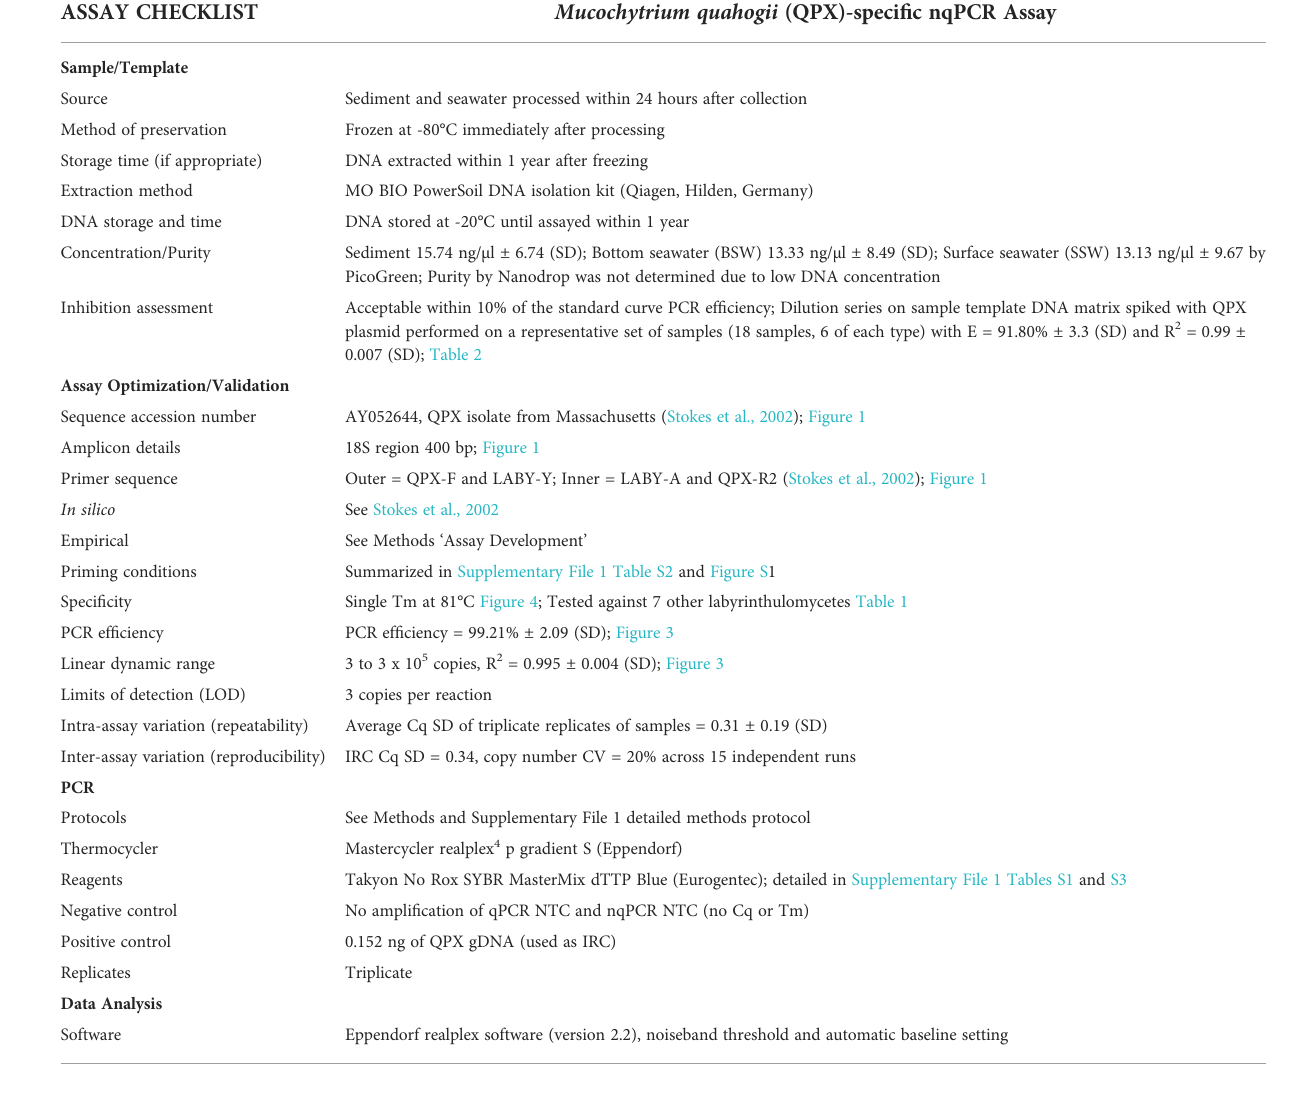
TABLE 4 Modi fi ed MIQE checklist for the nqPCR